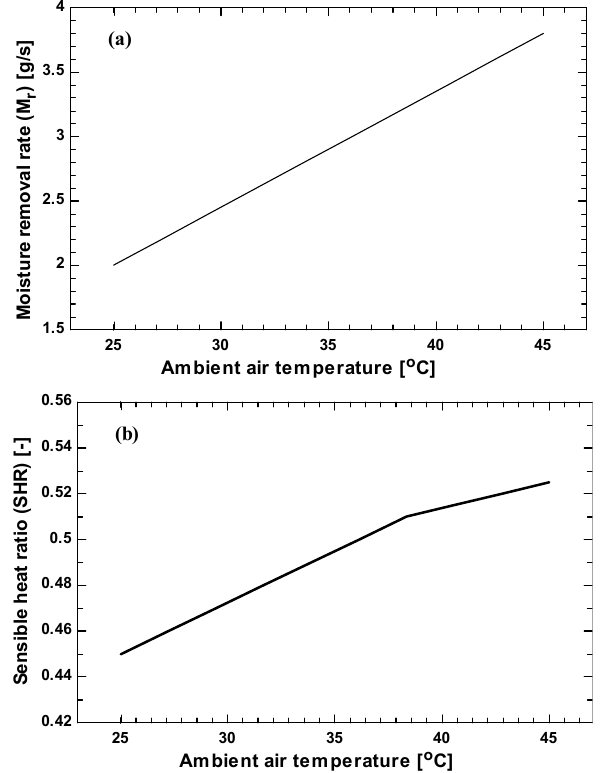
Figure 3. Effect of ambient air temperature on ( a ) moisture removal rate ( M r ); ( b ) sensible heat ratio (SHR). Table 5. Effect of ambient temperature on the system performance.